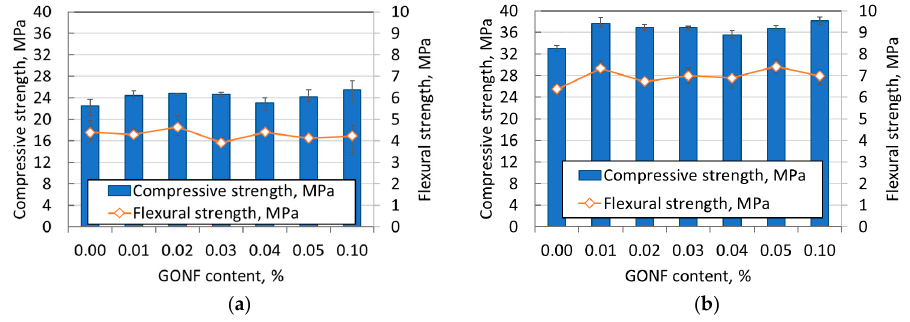
Figure 9. Compressive and flexural strength results of GONF-combined concrete with Dry-mix design. ( a ) Mechanical properties of CD (7 days); ( b ) Mechanical properties of CD (28 days).